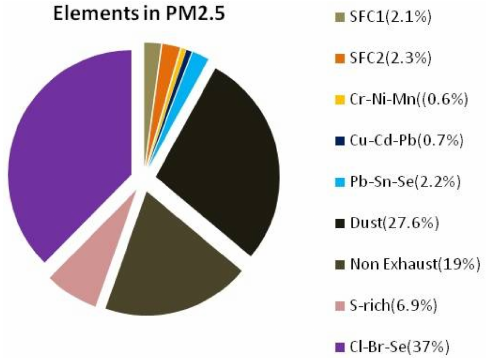
Figure 2. Fractional contributions of the factors of elements in PM 2.5 samples collected in Delhi inwinter